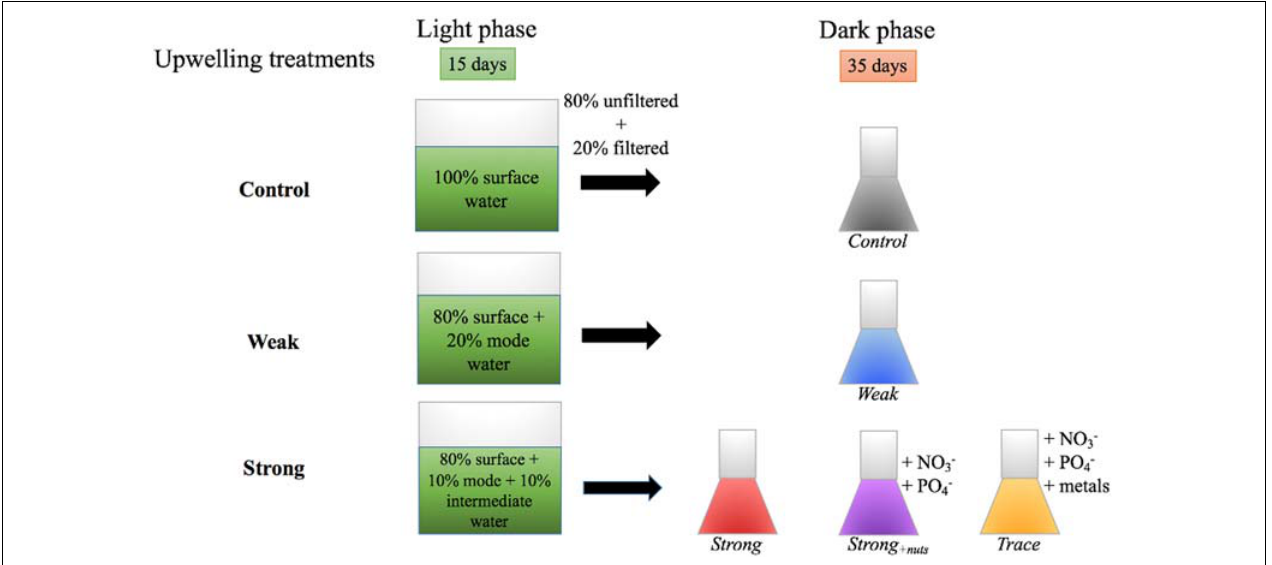
FIGURE 1 | Incubation scheme for the upwelling simulations. The experiments involved a 15 days light treatment followed by 35 days dark incubations, the latter with and without inorganic nutrient additions (red and purple vials), and trace metals (yellow vial).